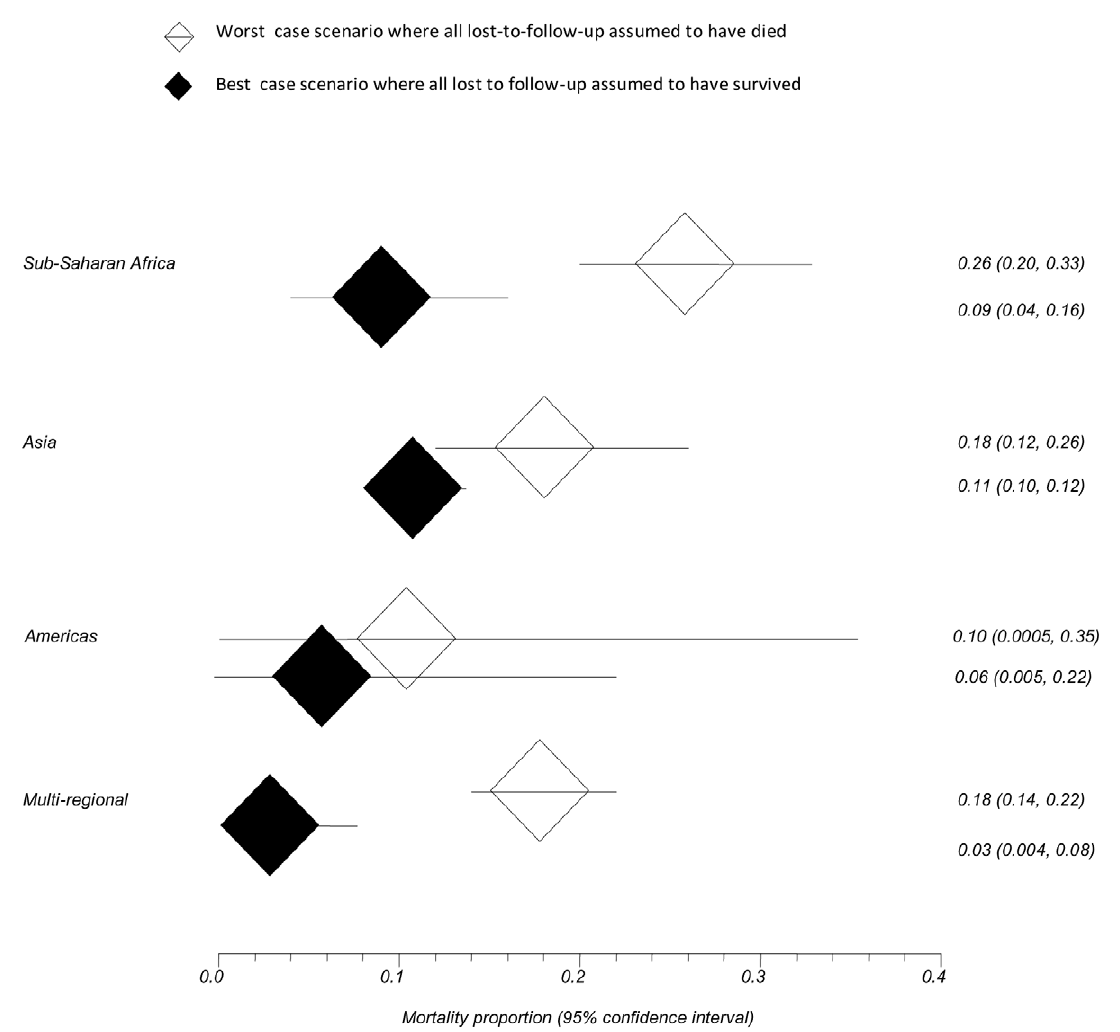
Figure 3. Sensitivity analyses for pooled regional estimates of mortality at 12 months by best case (all loss-to-follow-up assumed to have survived) and worst case (all lost-to-follow-up assumed to have died) scenarios.